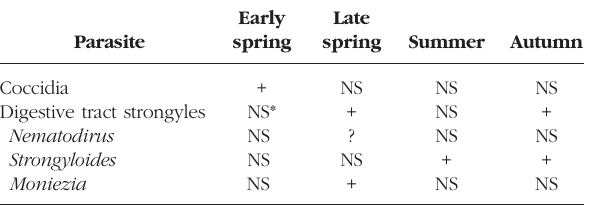
* non significant relationship. Table I. – Associations of Disco 3 (Diarrhoea) and internal parasites of lambs along the year in semi-montane climate (Auvergne-France) (modified of Cabaret et al. ,